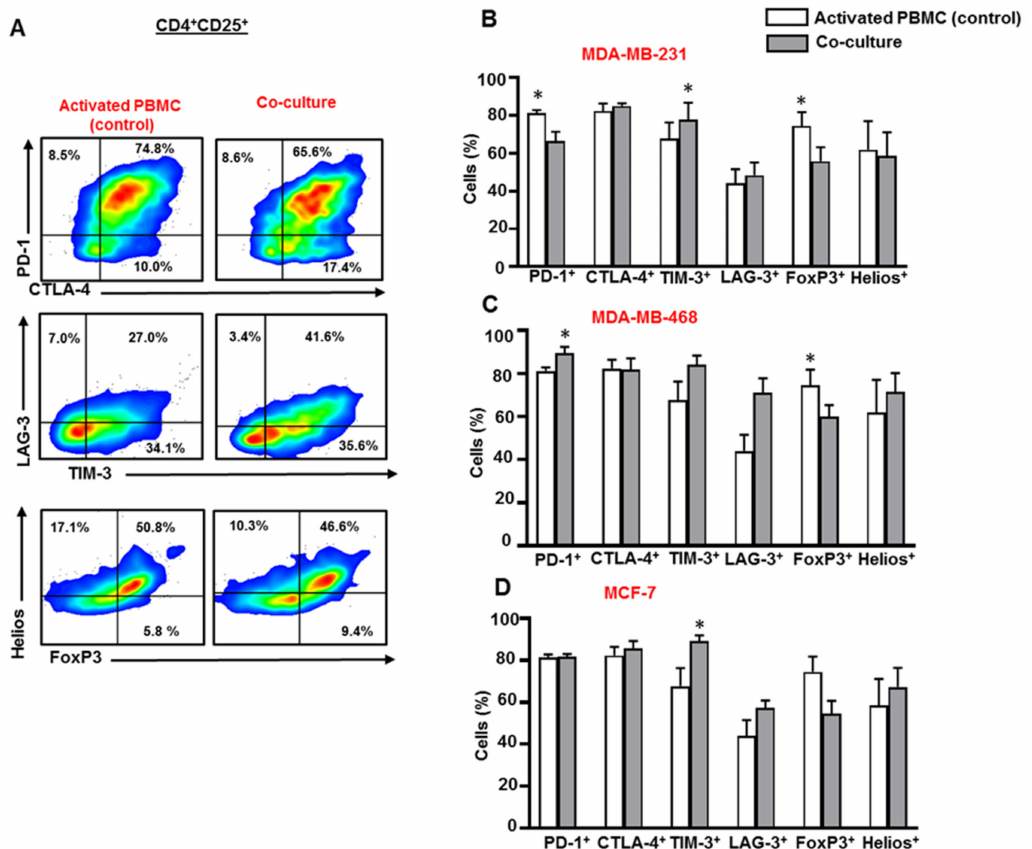
Figure 3. Immune checkpoint and Treg-related marker expression on CD4 + CD25 + T cells in co-culture with breast cancer cells. Activated PBMCs were co-cultured with MDA-MB-231, MDA-MB-468, and MCF-7 cells for 72 h. Cells were then stained for immune checkpoints and FoxP3 / Helios expression, and analyzed by flow cytometry. Representative flow cytometric plots show PD-1, CTLA-4, TIM-3, LAG-3, FoxP3 and Helios expression in CD4 + CD25 + T cells from activated PBMC and MDA-MB-231 co-culture ( A ). Bar plots show the di ff erences in IC, FoxP3 and Helios expression in CD4 + CD25 + T cells in the presence or absence of MDA-MB-231 ( B ), MDA-MB-468 ( C ) and MCF-7 ( D ) cells. Data represent the mean + SEM of four independent